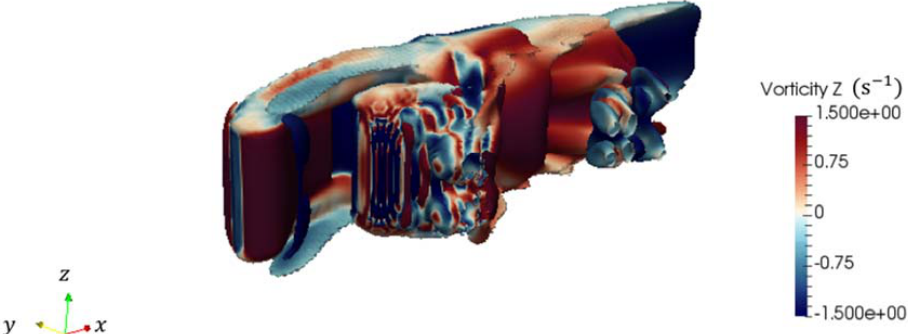
Figure 10. Snapshot of vorticity iso ‐ surfaces, coloured according to 𝑧 ‐ component.